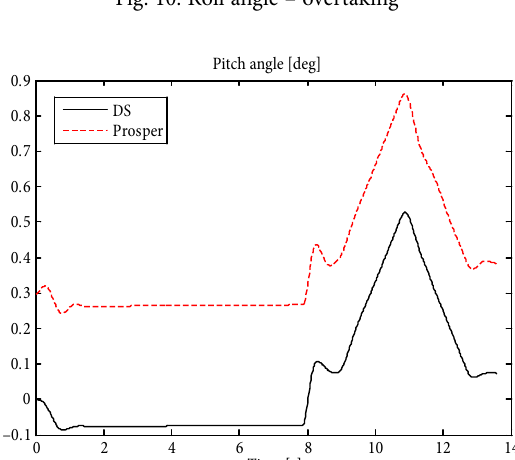
Fig. 10. Roll angle – overtaking